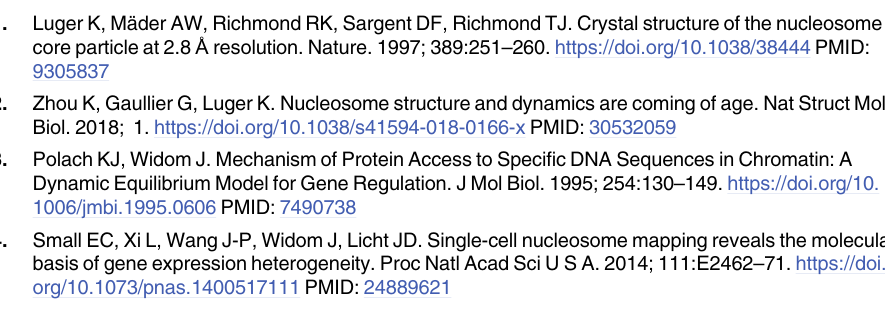
S1 Data. Coordinates of metastable states. For each of the 11 metastable states identified from our MSM at 400 mM using PCCA clustering, we deposited 4 representative coarse- grained nucleosome conformations in PDB format. The conformations are named “sta- te � conf#.pdb”, where � corresponds to the state name as described in the text (T, T H , H , H , H , H and H , N), and # goes from 1 to 4. The file “msm_hmm11.dat” con- L1 L2 R0 R1 R2 R3 tains the equilibrium probabilities of the various basins and the transition probabilities between them. The data also contain 4 representative partially opened conformations for each of the left hexasome, right hexasome, and tetrasome states, named “partially-opened_ � _conf#. pdb”, where � is H , H or T and # goes from 1 to 4. L R S2 Data. MD simulation setup. Example CafeMol input files used to run nucleosome assem- bly simulations as described in the Methods